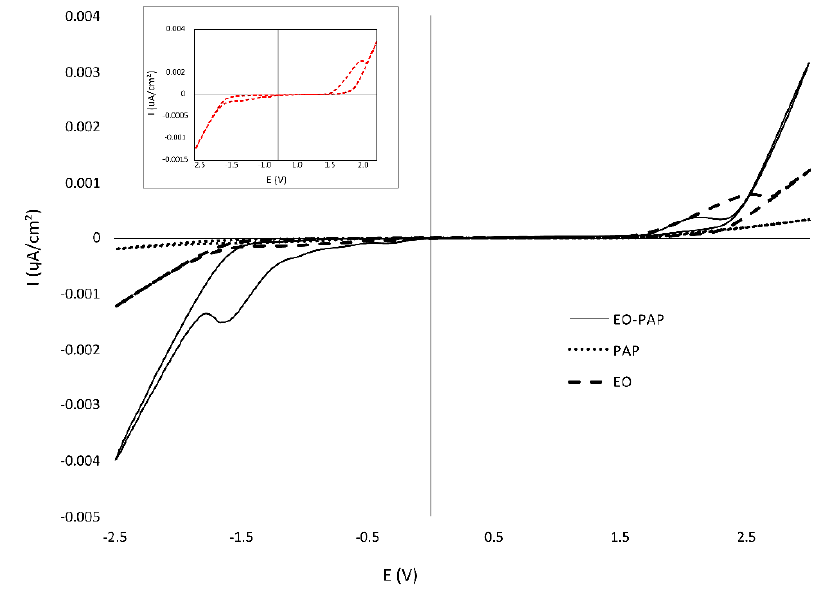
Figure 9. Cyclic voltammetry of 5 mg · L − 1 of azo dye Carmoisine in 0.05 M H 2 SO 4 after three process (EO / PAP and EO–PAP). The scan rate was 100 mV · s − 1 . Electrodes CE: Pt, RE: Ag / AgCl, WE: BDD.